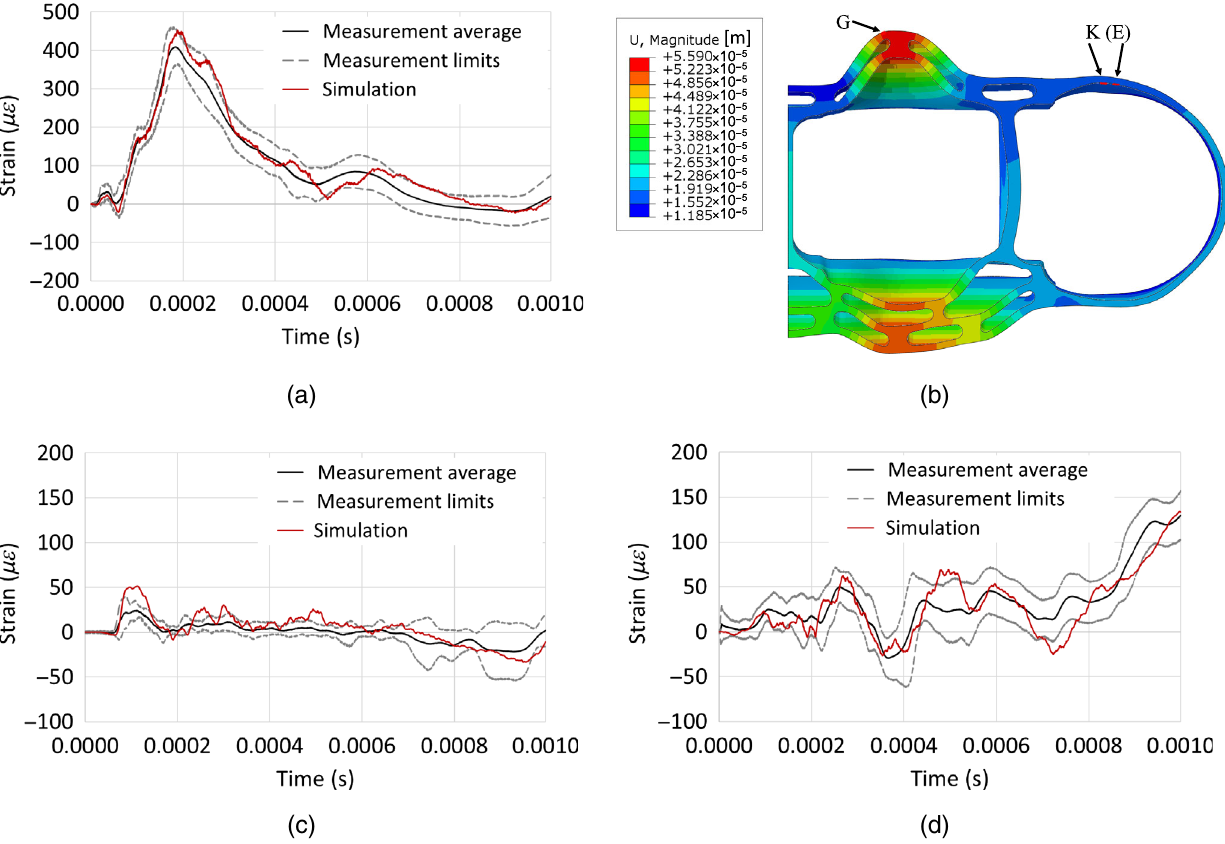
FIG. 15. Strain responses and deformed shape in the middle of the target. (a) Sensor G (4.6 cm from center-transverse direction). (b) Deformed shape (magnified 500×) of the target at 0.2 ms when the strain peak of sensor G occurs (left and right sensors in the same side of half symmetry model). (c) Sensor E (left-beam direction). (d) Sensor K (right-transverse